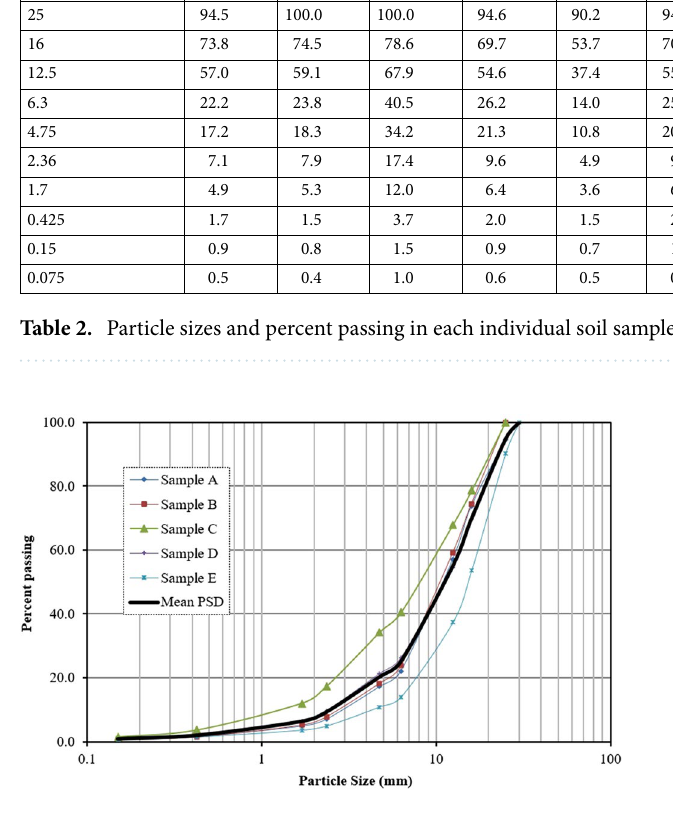
Figure 2. Particle size distribution of several samples and mean PSD used for preparing shear box